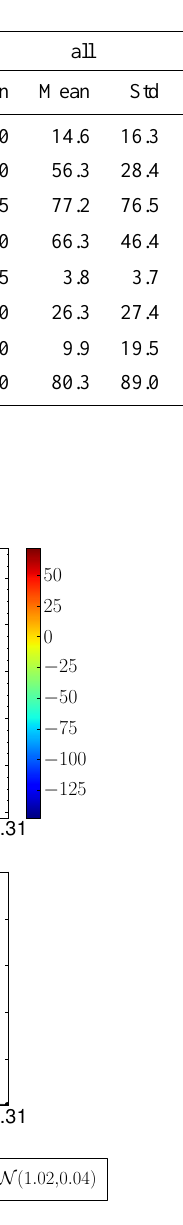
Table A3. Summary of aerosol observations, from 8 to 10km, used for evaluation (all) and for initialization (initial) from the INTEX-A observational campaign. Unless otherwise noted values, are in parts per trillion (ppt).